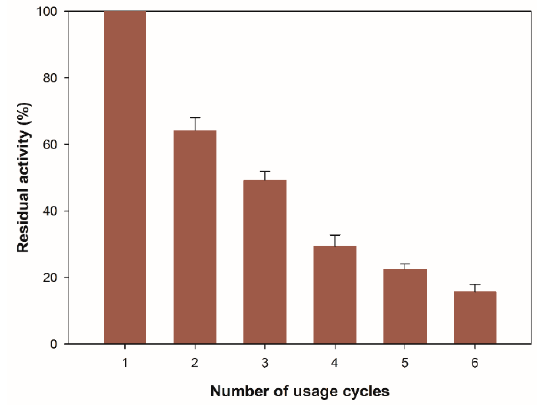
Figure 6. Reusability of immobilized β -glucosidase. All values are the mean of three replicates. Error bars represent the standard deviation within the data set.